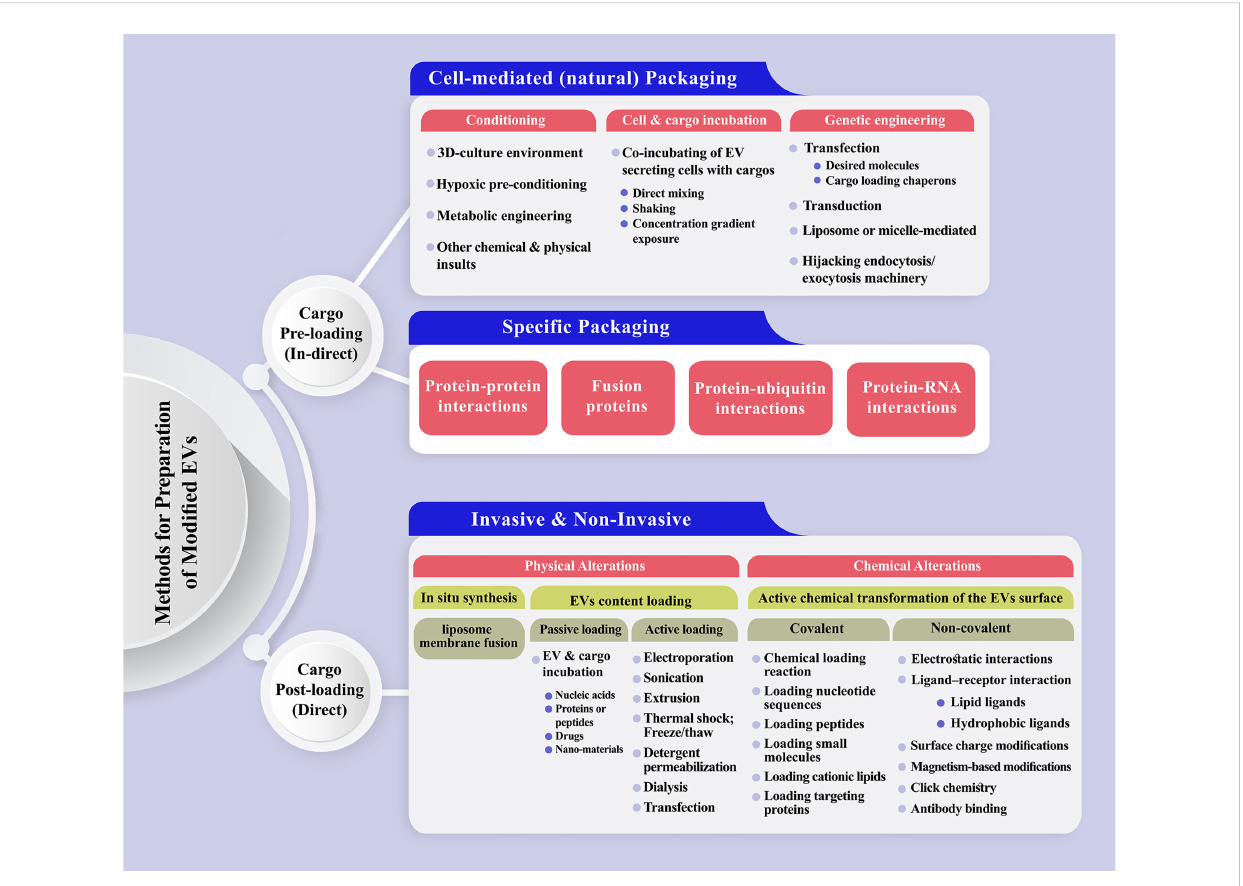
FIGURE 3 A schematic representation of the methods has been proposed to prepare engineered extracellular vesicles. (Top) Cargo pre-loading (in-direct) path is subdivided to cell-mediated and speci fi c packaging fashion. The latter one could be designed based on protein-protein, protein-RNA, protein- ubiquitin interactions or the production of fusion proteins. (Bottom) Direct EV post-loading is achievable via physical and chemical modi fi cations which are the two major ways for transferring the cargo of interest to EVs. Physical alterations mostly include passive and active loading techniques. Incubating EVs with the cargo of interest (passive loading) is a convenient and effective way, which was applied to load EVs with nucleic acids, proteins or peptides, drugs, and nano-materials. Electroporation, sonication, extrusion, thermal shock, detergent permeabilization, dialysis, and transfection are the main active loading techniques for intensifying the content of EVs in the bene fi t of desirable molecule/s. Covalent and non- covalent interactions are proposed as active chemistry methods to modify the inner or outer surface of